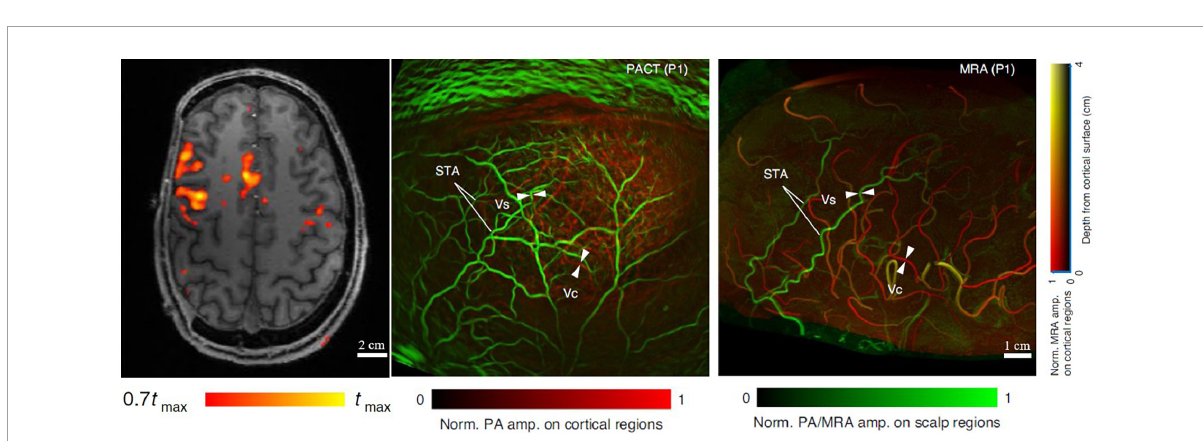
FIGURE5 MRI, MRA, and PACT images of the brain of a hemicraniectomy patient (Na et al., 2022). (Left) Representative transverse MRI slice with fMRI data overlaid. (Middle) PACT vasculature of the brain. (Right) Corresponding MRA vasculature of the brain. Scalp vessel (Vs), cortical vessel (Vc), and superficial temporal arteries (STA) were used for comparison between MRA and